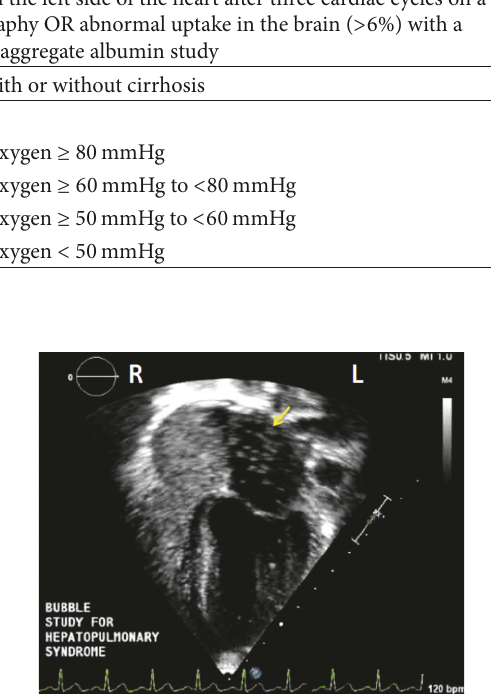
Figure 1: Two-dimensional contrast echocardiography showed the presence of bubbles in the left atrium after 7 cardiac cycles (yellow arrow), consistent with an intrapulmonary shunting (R: right, L: